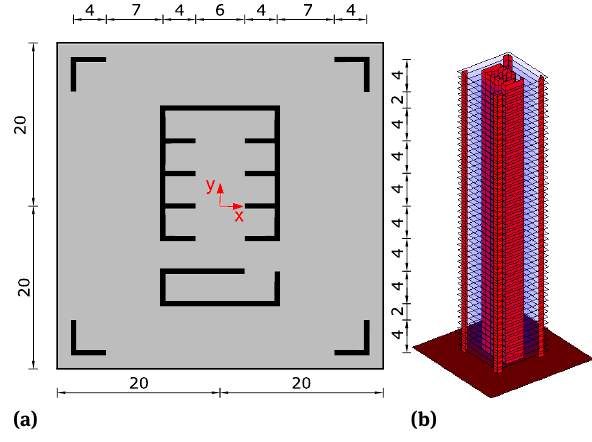
Figure 2: (a) Floor plan of the building (dimensions in meters); (b) 3D-model of the building